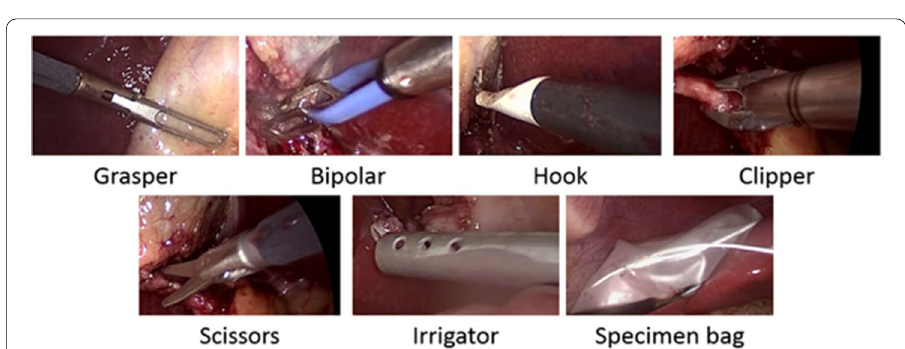
Fig. 4 Seven surgical tools included in the CHOLEC80